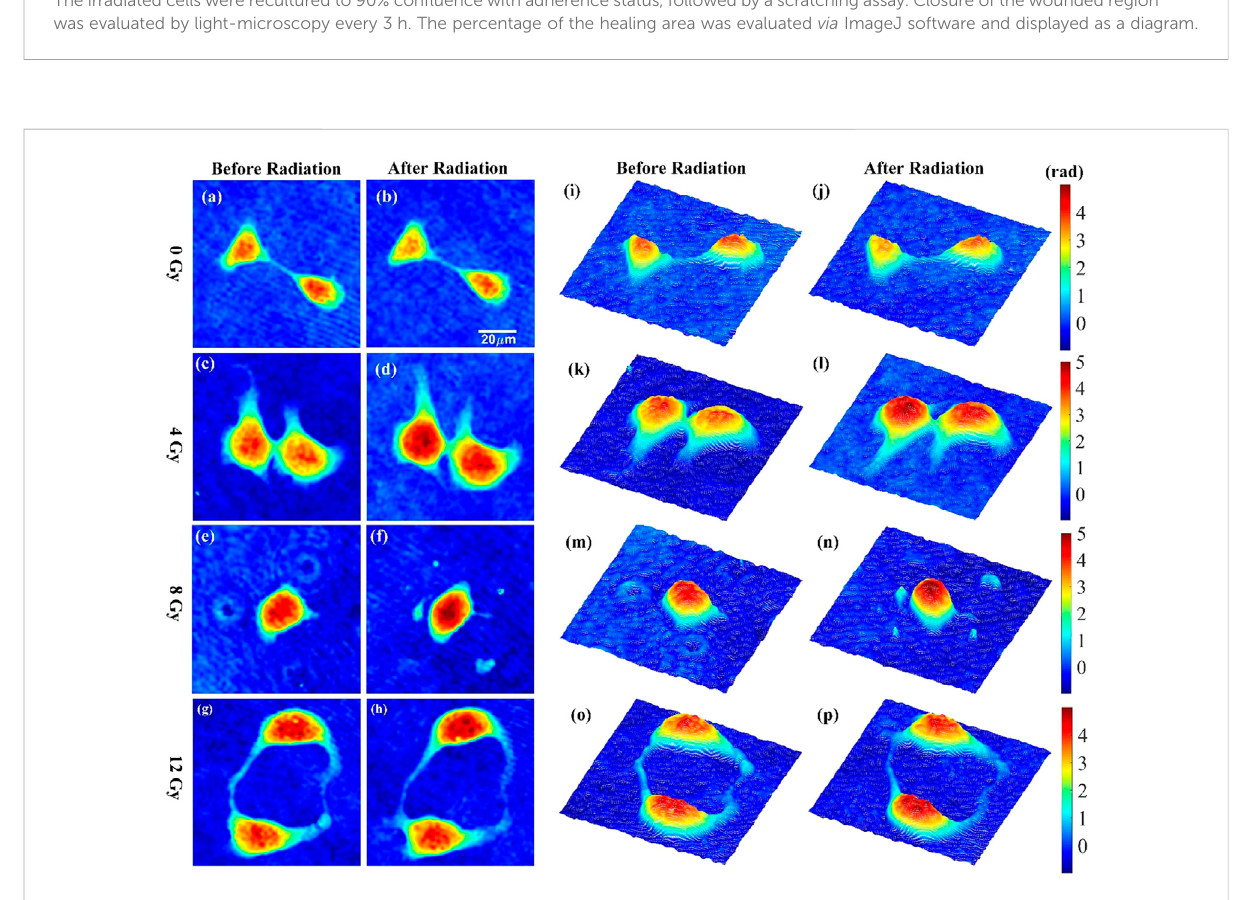
FIGURE 5 Phase images and corresponding pseudo-three-dimensional images of HT-1376 cells before and after radiation for 0, 4, 8, and 12